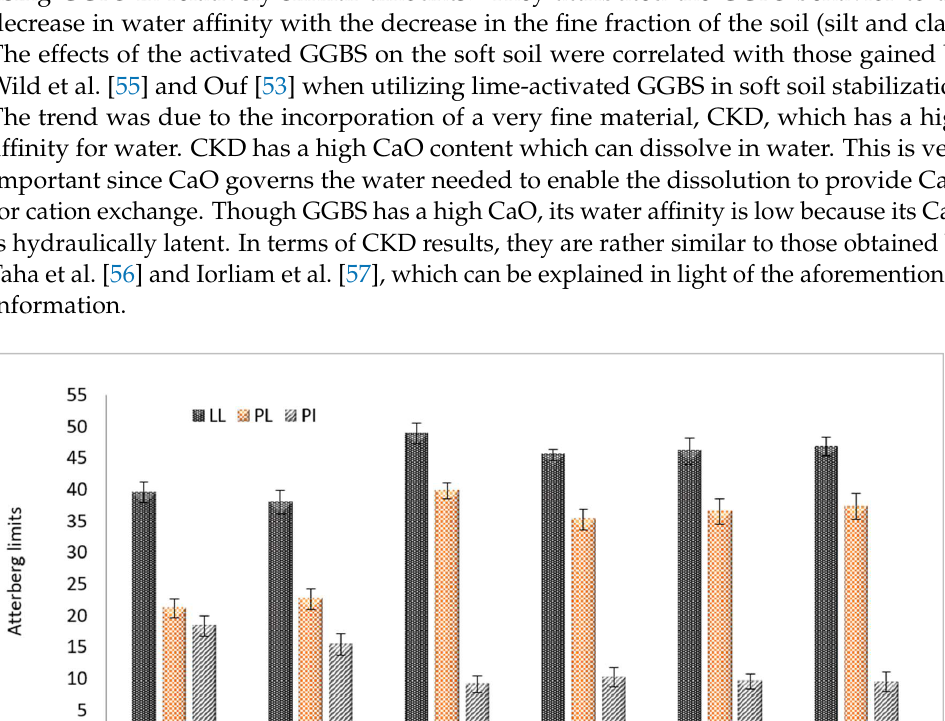
Figure 3. UCS of soil with different GGBS contents at 7 and 28 days of curing.